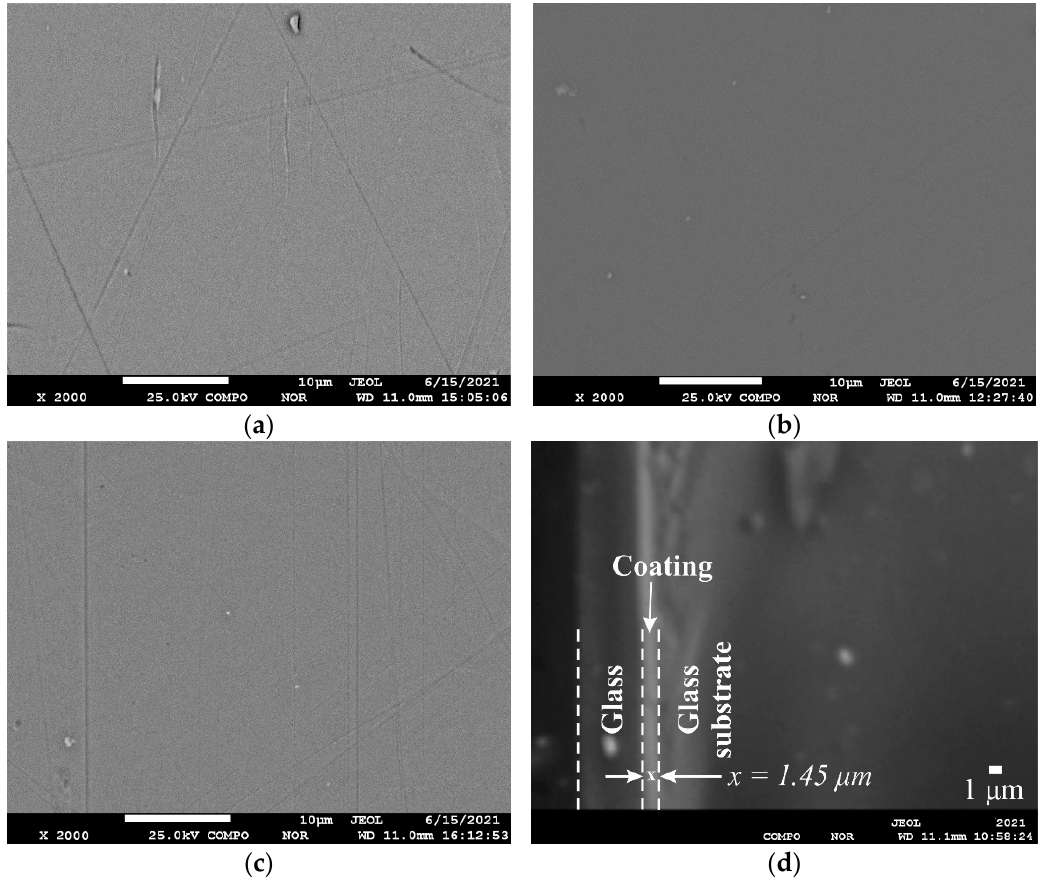
Figure 2. SEM images of the morphology and coating thickness of TiCN coatings obtained at different substrate bias voltage: ( a ) 0; ( b ) − 70 V; ( c ) − 100 V; and ( d ) coating thickness obtained at without substrate bias voltage 0 V.